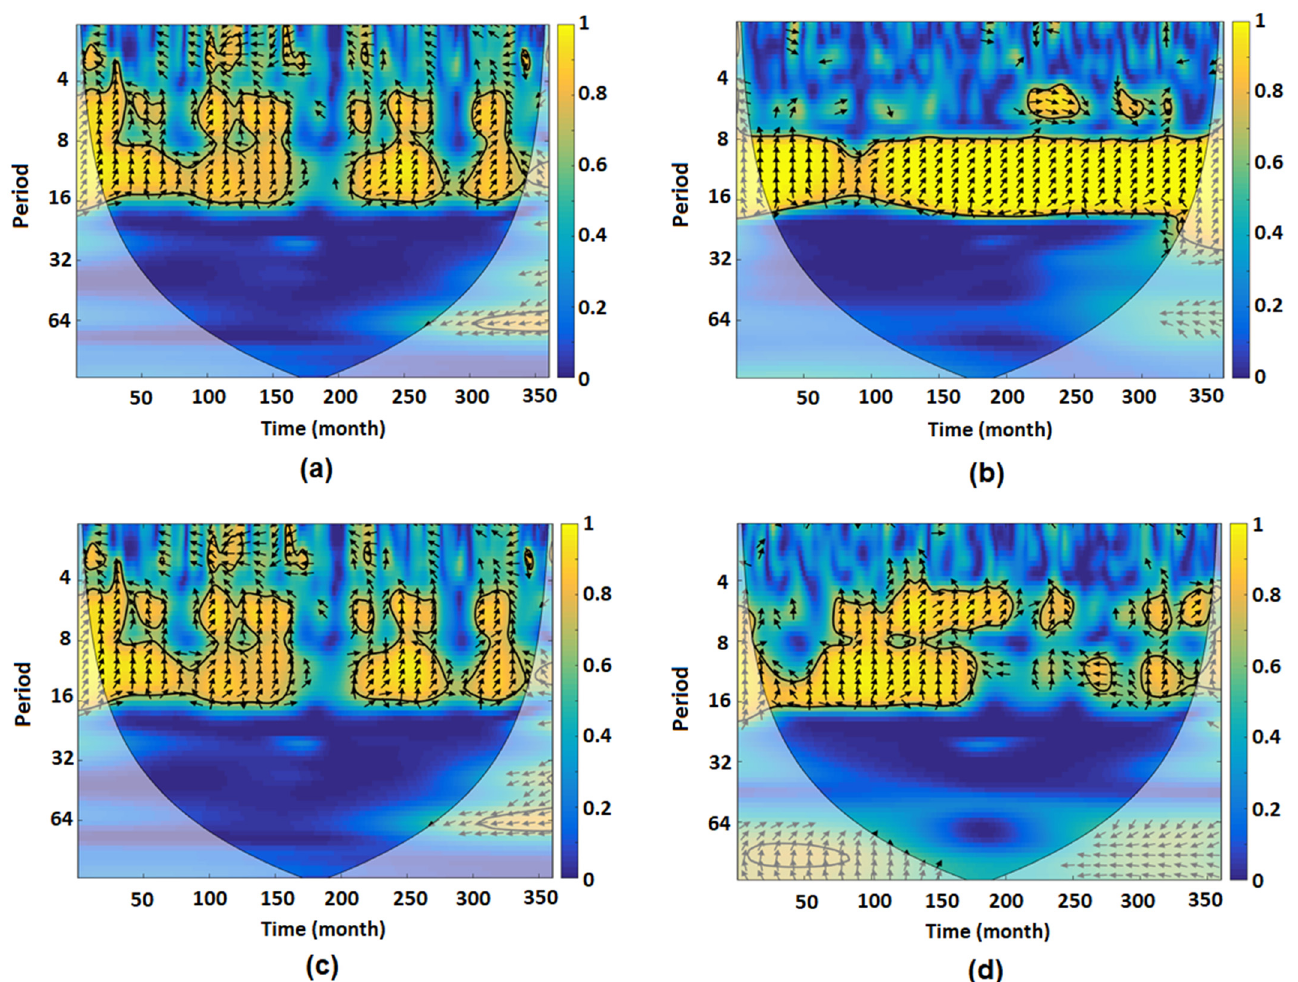
Figure 6. Wavelet transform coherence for the variables in the AC watershed between NDVI and ( a ) streamflow (Akhola), ( b ) temperature, ( c ) streamflow (Markid), and ( d ) precipitation.